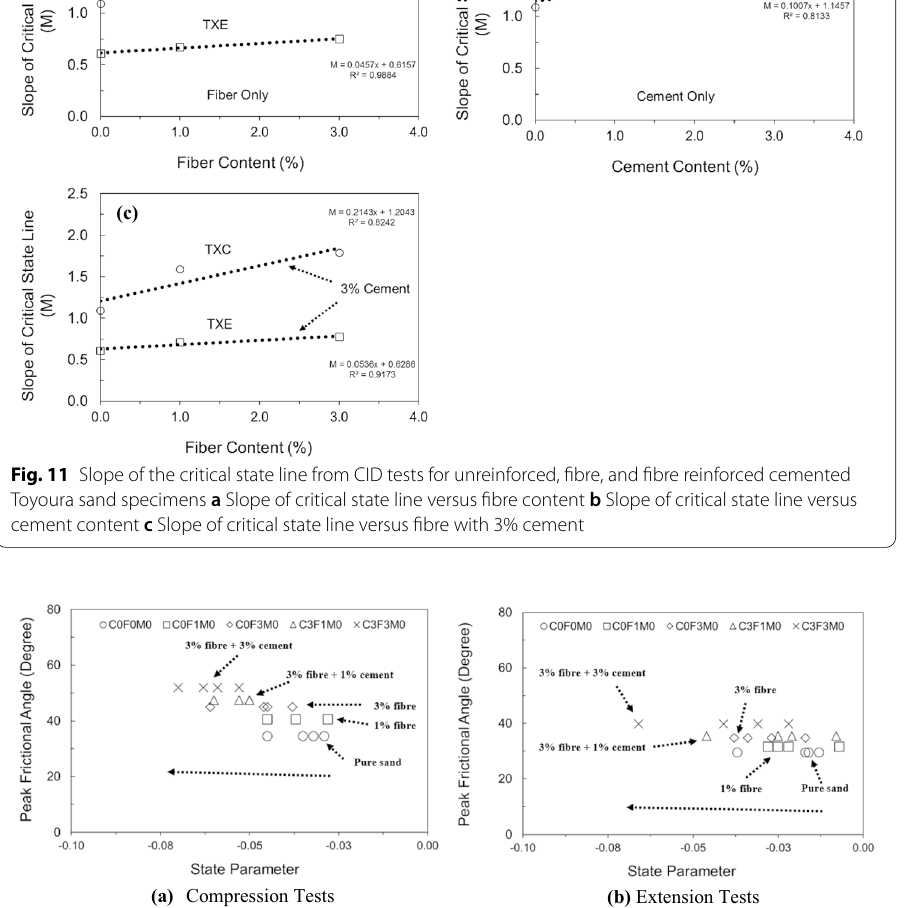
Fig. 12 Peak frictional angle vs. state parameter from CID compression and extension tests for unreinforced, fibre, and fibre reinforced cemented Toyoura sand specimens a Compression tests b Extension